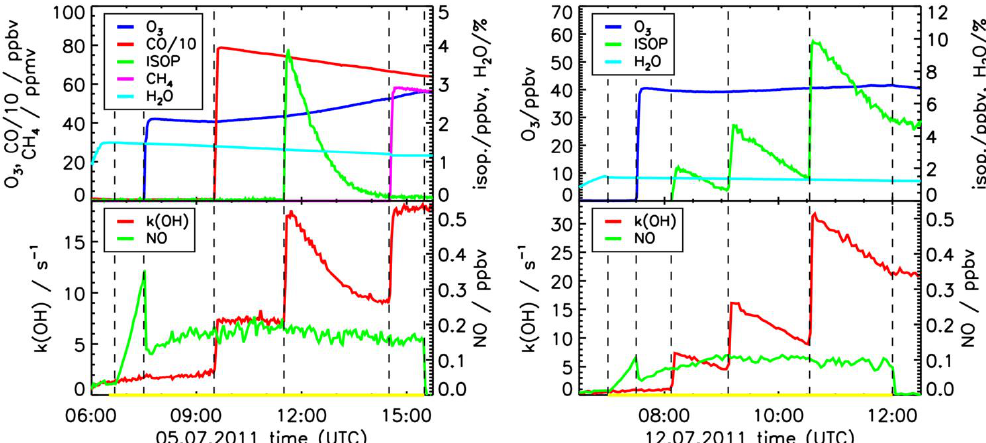
Fig. 1. Typical sequence of trace gas additions during experiments. The organic compound of interest (here isoprene) was injected either once (left panel) or several times (right panel). Dashed vertical lines indicate times when trace gases were injected or the chamber roof was opened or closed. The period of time when the chamber was illuminated by sunlight is shown by horizontal yellow lines.